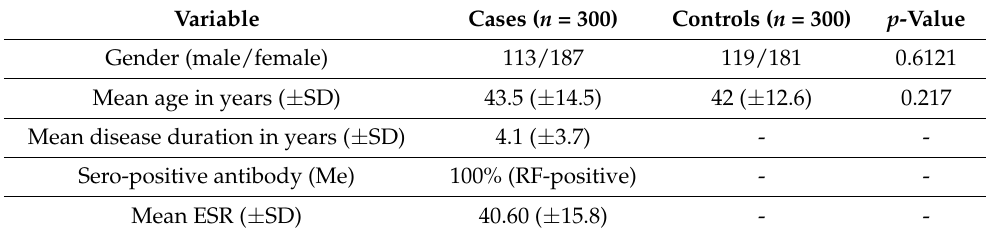
Table 1. Characteristics of Rheumatoid Arthritis Patients and Controls.